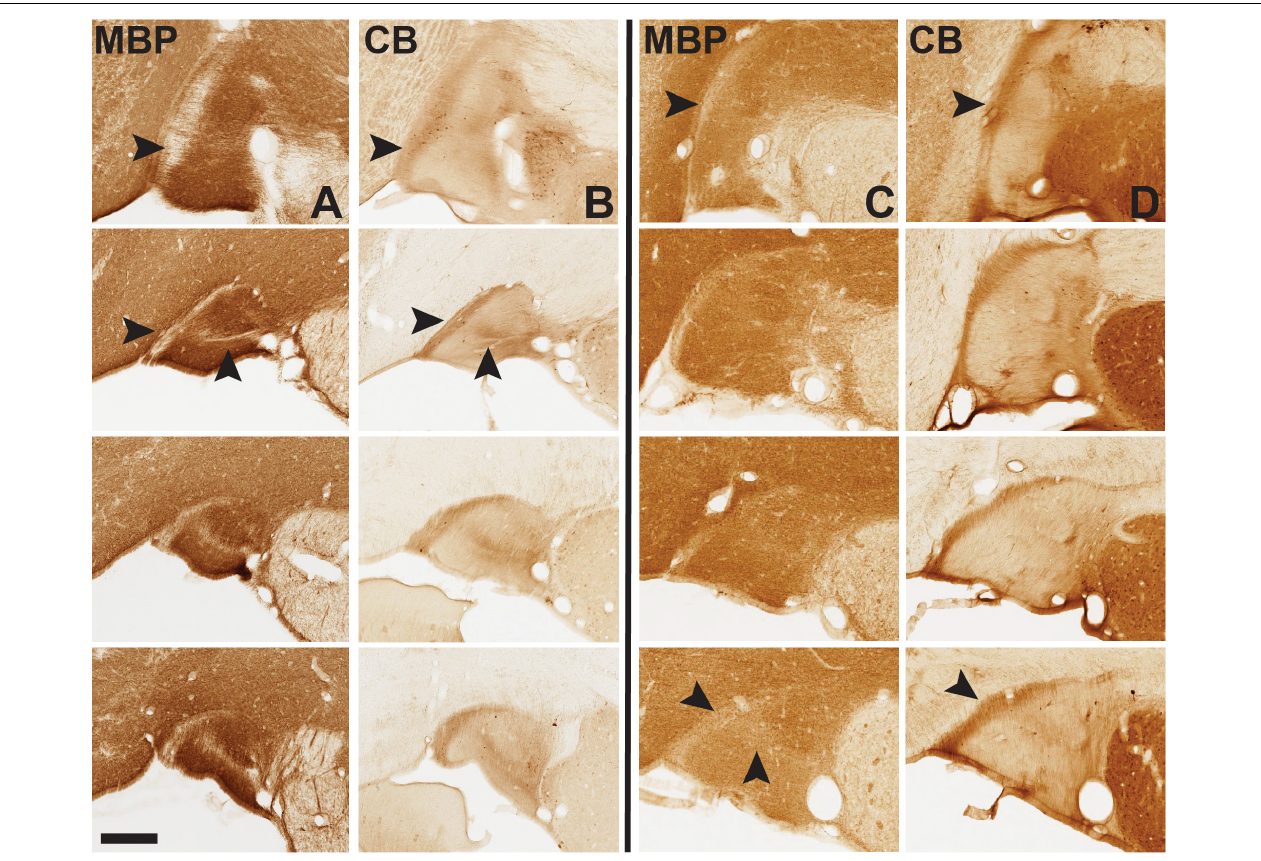
FIGURE 7 | Immunohistochemistry (IHC) for myelin basic protein (MBP, A and C columns) and calbindin (CB, B and D columns) demonstrates complementary fiber patterns, shown here for vST in infant brain 61 (left of the solid black line) and adult brain 72 (at right). Anterior sections are at the top, to more posterior at the bottom of the vertical rows for MBP and CB. Note prominent MBP-sparse band at the medial edge of the ST, which coincides with a dense CB + band (arrowheads in top horizontal row). At mid and posterior levels, the band has a horizontal ML component and appears more like a "Y" (second arrowhead), most prominent in the infant and much less in the adult, especially toward posterior levels. Medial is to the left. Scale bar = 350 µ m. For reference, the most posterior B61 MBP image is from section 39 of that series. For higher magnification views here (and throughout) please visit Collection 6 in MacBrainResource.